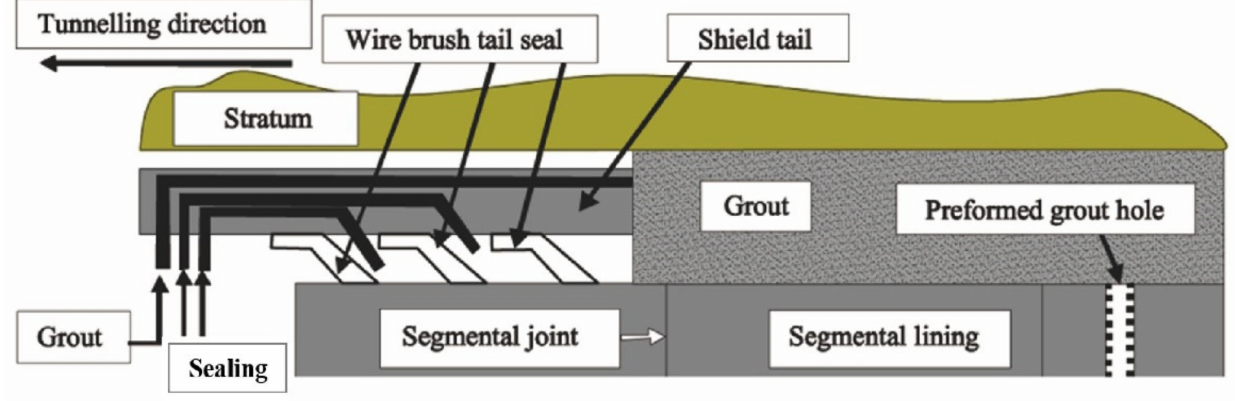
Figure 1. Schematic drawing of a shield tail seal